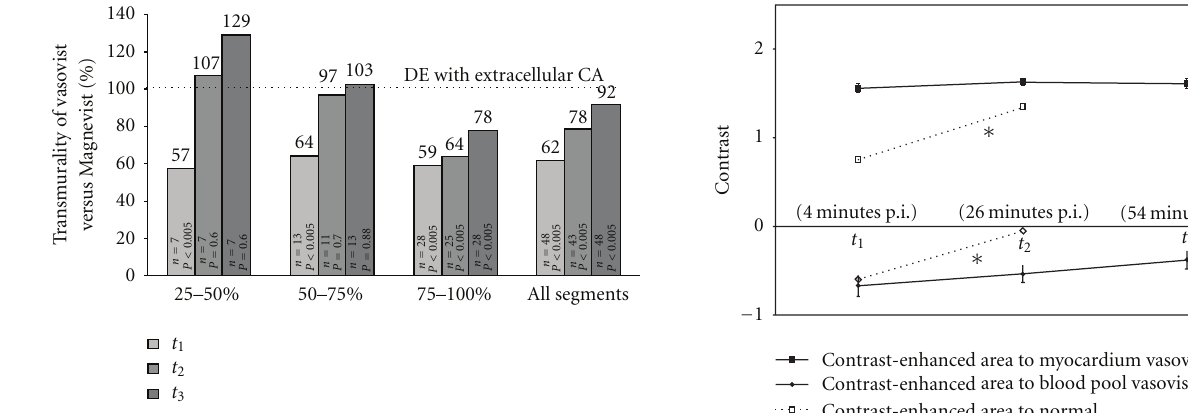
Figure 2: This figure shows the mean transmurality detected with MS-325 as a percentage of the transmurality previously detected with the extracellular CA (LGE). The columns show the results grouped for di ff erent degrees of transmurality with extracellular CA. Transmurality at t 1 was underestimated with MS-325 indepen- dent of transmurality, while transmurality of 25–50% at t 2 (107%) and transmurality of 25–50% and 50–75% at t 3 were overestimated (129% and 103%, resp.) using MS-325.